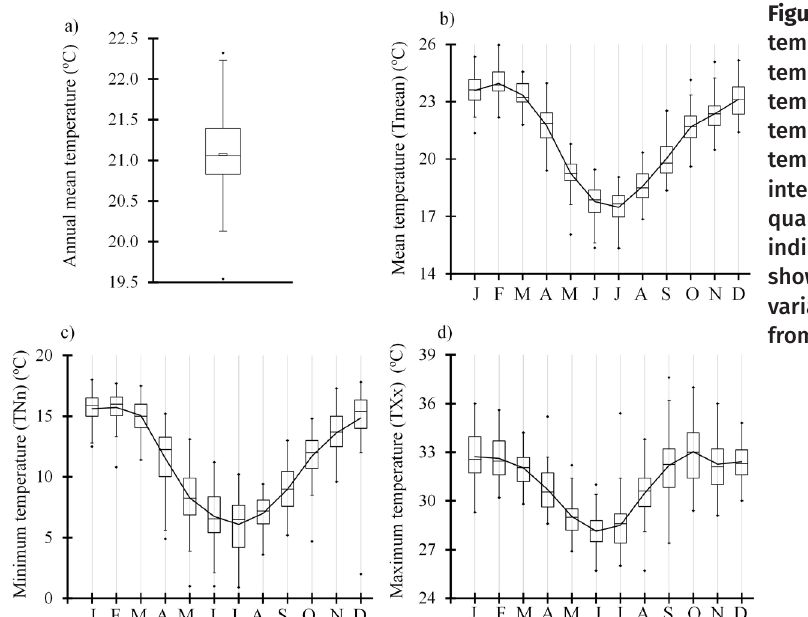
Figure 2 . Annual cycle of the air temperature: (a) Annual mean temperature, (b) monthly mean temperature, (c) monthly minimum temperature and (d) monthly maximum temperature. Boxes represents the interquartile spread (25 th and 75 th quantiles) with the horizontal line indicating the median and the whiskers showing the extreme range of the variables; solid line indicates mean from